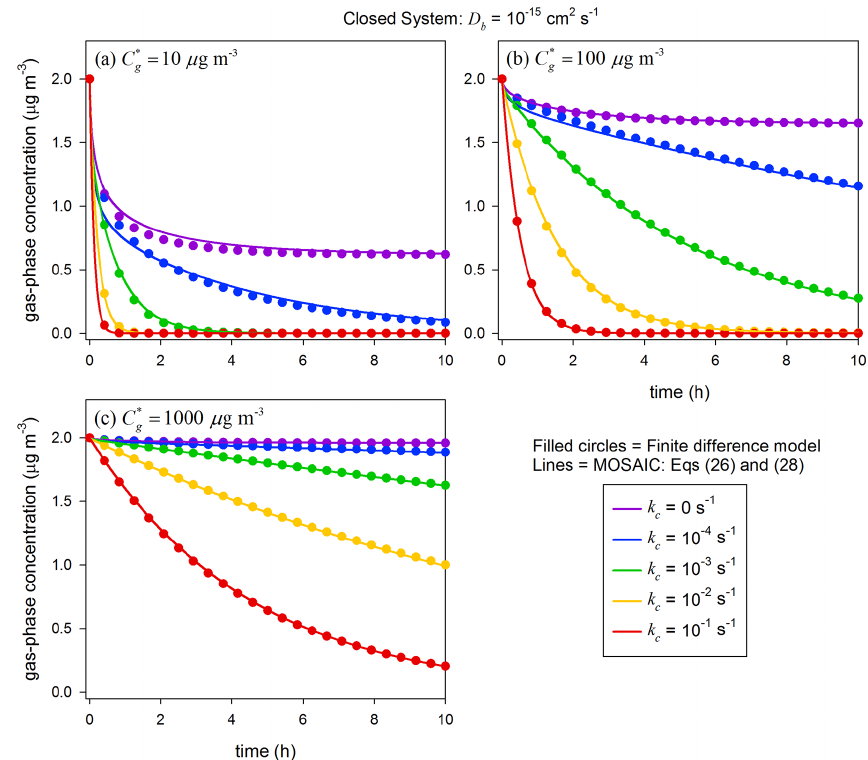
Figure 9. Comparison of MOSAIC (lines) and finite-difference model (filled circles) solutions for gas-phase concentration decay in a closed system due to kinetic gas-particle partitioning to particles with initial D p = 0.2µm, N = 5000cm − 3 , D b = 10 − 15 cm 2 s − 1 and k c ranging from 0 to 0.1s − 1 for three solute volatilities: (a) C ∗ g = 10µgm − 3 , (b) C ∗ g = 100µgm − 3 , and (c) C ∗ g = 1000µgm − 3 . Table 1. Bias and error statistics for MOSAIC predictions for the closed system